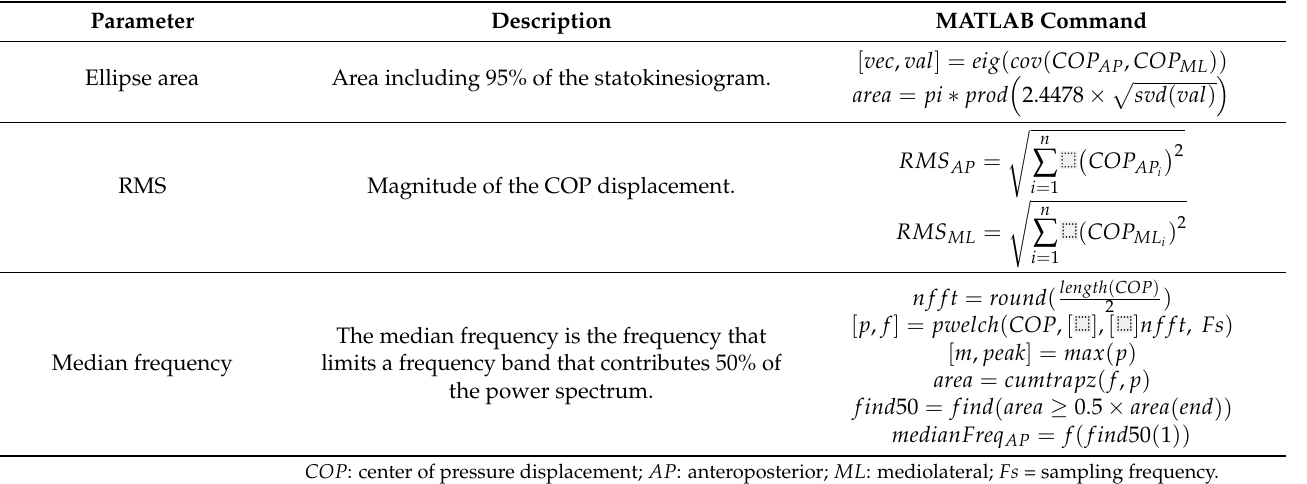
Table 1. MATLAB commands for global parameters. Parameter Description MATLAB Command Ellipse area Area including 95% of the statokinesiogram.